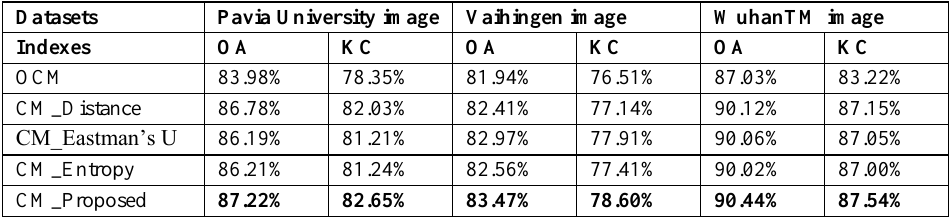
Table 1. Classification accuracy of the Pavia University image, Vaihingen image and WuhanTM image